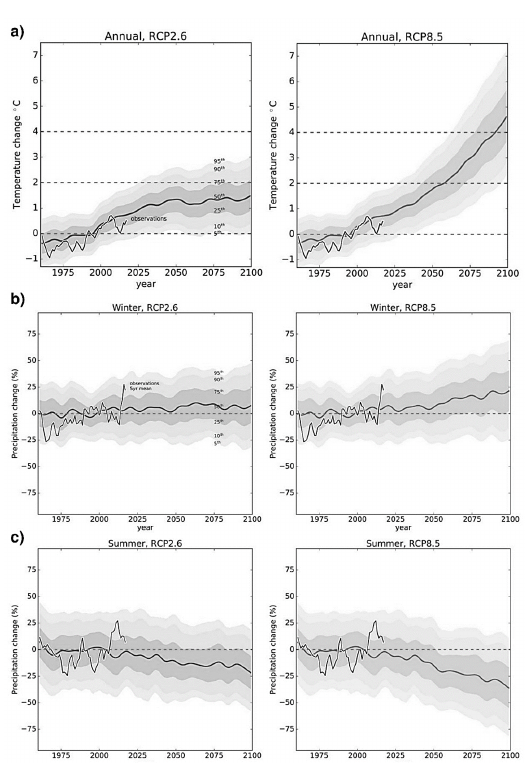
Figure 6. UK weather data (black lines) and UKCP18 (grey lines) forecasts (5th, 10th, 25th, 50th, 75th, 90th, and 95th percentiles are shaded) represented in terms of ( a ) mean temperature; ( b ) percentage summer precipitation change; and ( c ) percentage winter precipitation change, for both RCP 2.6 and 8.5 (contains public sector information licensed under the Open Government Licence v3.0, http://www.nationalarchives.gov.uk/doc/open ‐ government ‐ licence/version/3/, (accessed on 2 October 2021), © Crown copyright, Met Office, [8]).